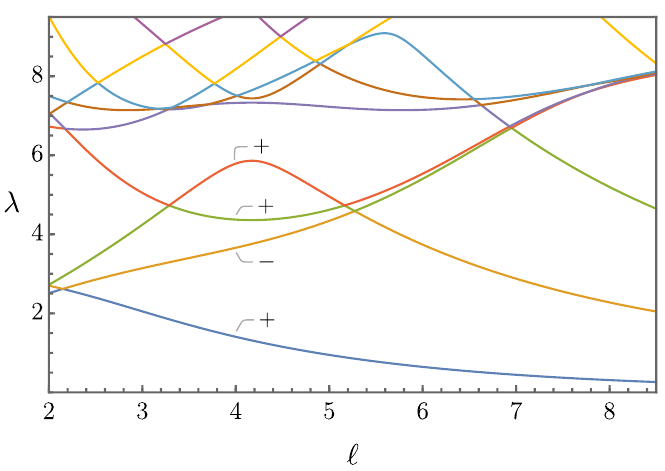
Figure 4 . Low-lying eigenvalues of the Laplace-Beltrami operator for the closed genus-2 surfaces along the path ρ ( ‘ ) in Teichmüller space, defined in eq. (4.16), for ‘ ∈ [2 , 8 . 5] , computed using Hypermodes [9, 10]. The ± labels indicate the Z 2 parity of the first four nontrivial eigenfunctions at ‘ = 4